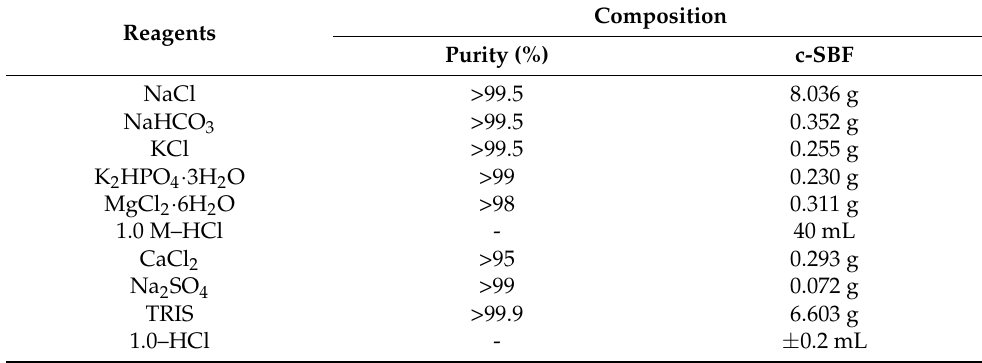
Table 2. Chemical composition of SBF solution (g · L − 1 ) [31]. Copyright 2003